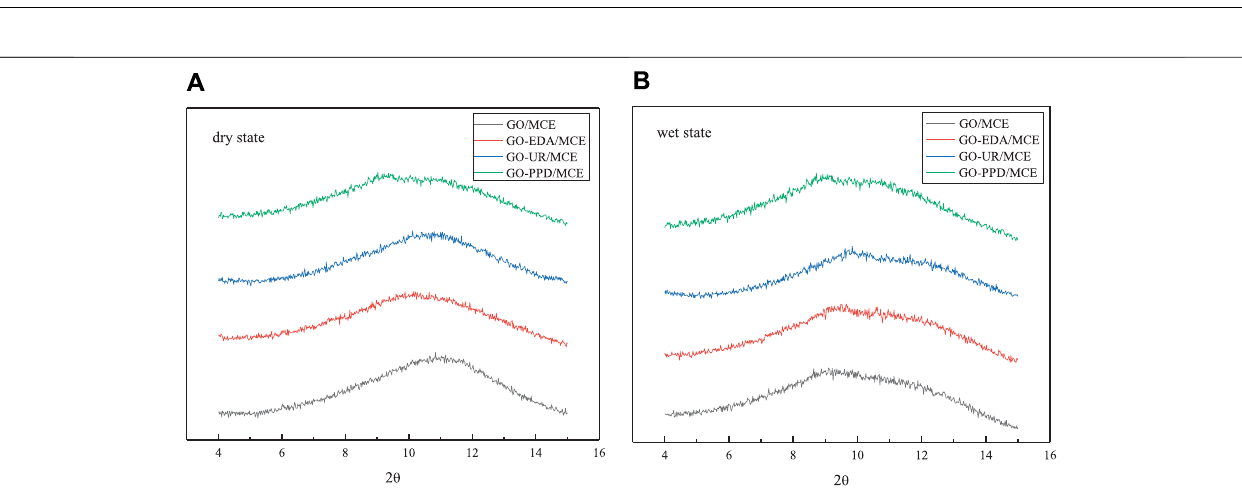
FIGURE 5 | XRD of four composite membranes (A) in the dry state, (B) in the wet state.